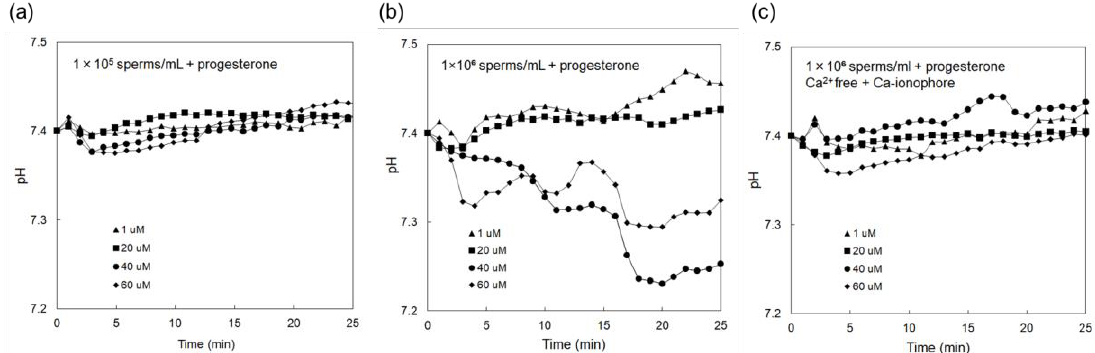
Figure 5. Change in pH of sperm-cultured gate ISFET sensor. Considering the pH sensitivity of the ISFET sensors (about 56 mV/pH on average) used in this study, the change in pH was calculated from the results plotted in Figure 3; ( a ) 1 × 10 5 sperm/mL, ( b ) 1 × 10 6 sperm/mL, ( c ) 1 × 10 6 sperm/mL in Ca 2+ -free HTF medium containing Ca ionophore.